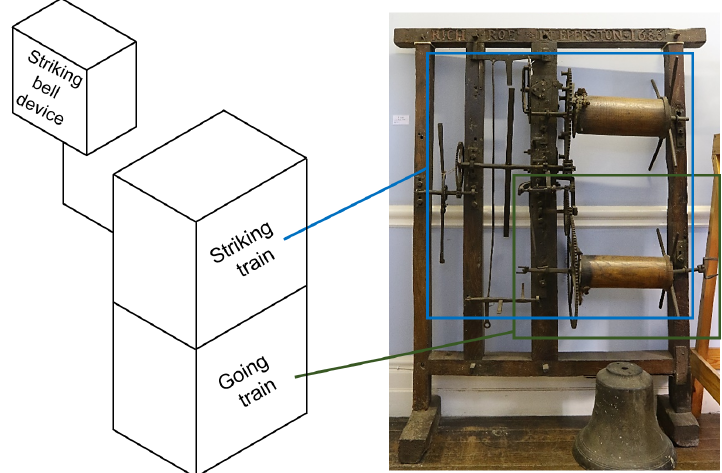
Figure 12. Structure of the Plumtree clock (N9) (Rabbott, 2018).